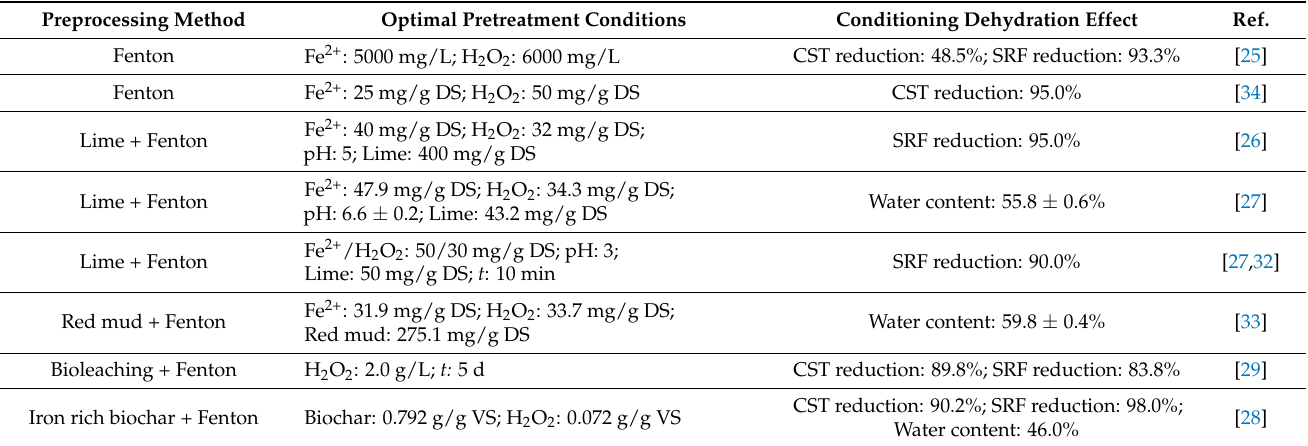
Table 1. Study results of enhanced sludge dewatering by hydrogen peroxide pretreatment. Preprocessing Method Optimal Pretreatment Conditions Conditioning Dehydration Effect